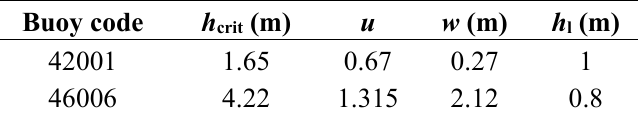
Table 1. Parameters of the cumulative distribution F H s ( h ) and significant wave height threshold chosen for storm identification h crit .